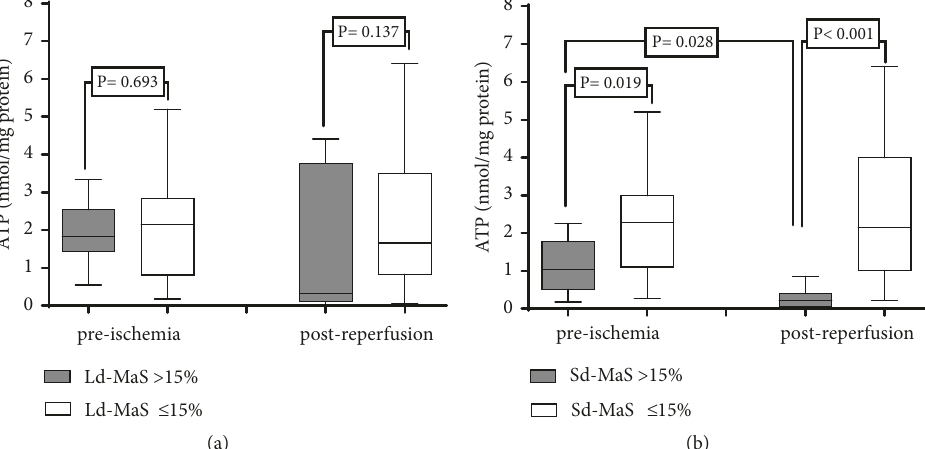
Figure 6: Graft ATP content at preischemia and postreperfusion according to graft large-droplet (Ld-MaS, (a)) and small-droplet (Sd-MaS,